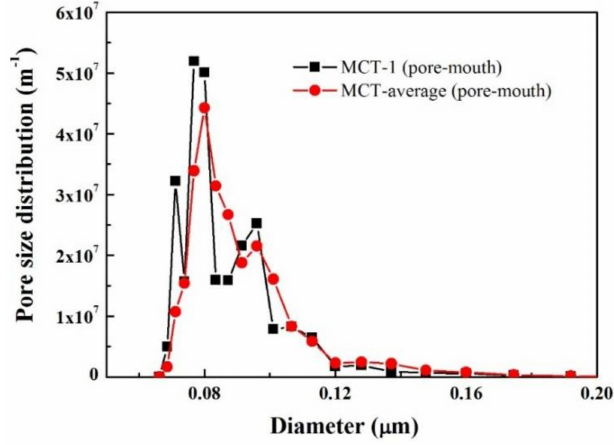
Figure 11. Averaged pore mouth size distribution for multichannel tubular ZrO 2 / γ -Al 2 O 3 / α -Al 2 O 3 membranes derived from six replicate samples. Table 8. Summary of MLLDP results for three replicate samples of nominal 100 nm